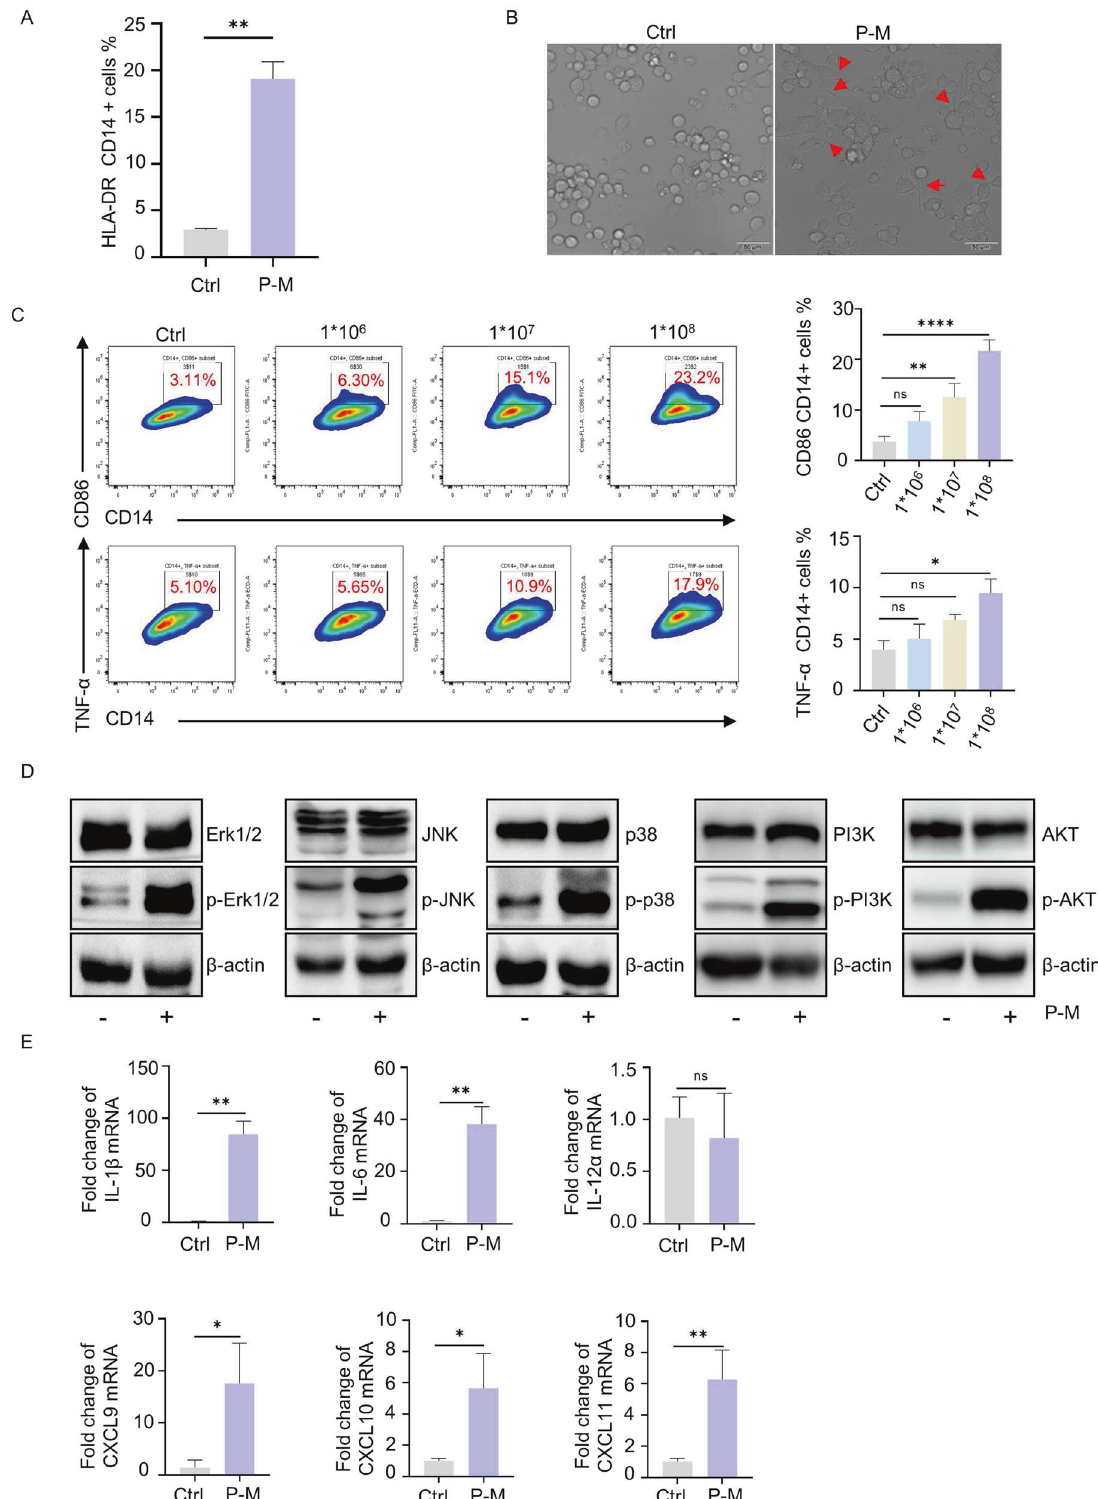
Fig. 1 PA-MSHA induced M1 macrophage polarization. A The expression of HLA-DR on THP-1 cells were enhanced by PA-MSHA (1 × 10 8 pcs/ ml). B Cell morphology of THP-1 after co-culture with PA-MSHA was changed, pseudopodia growth marked by red arrows. C PA-MSHA upregulated M1 marker CD86 and TNF- α in THP-1-derived macrophages. D PA-MSHA induced the phosphorylation of PI3K/AKT and p38/JNK/ Erk in THP-1 cells. E The mRNA level of IL-1 β , IL-6, IL-12 α and CXCL9-11 by q-PCR. P-M is short for PA-MSHA. (* P < 0.05, ** P < 0.01, *** P < 0.001, **** P <